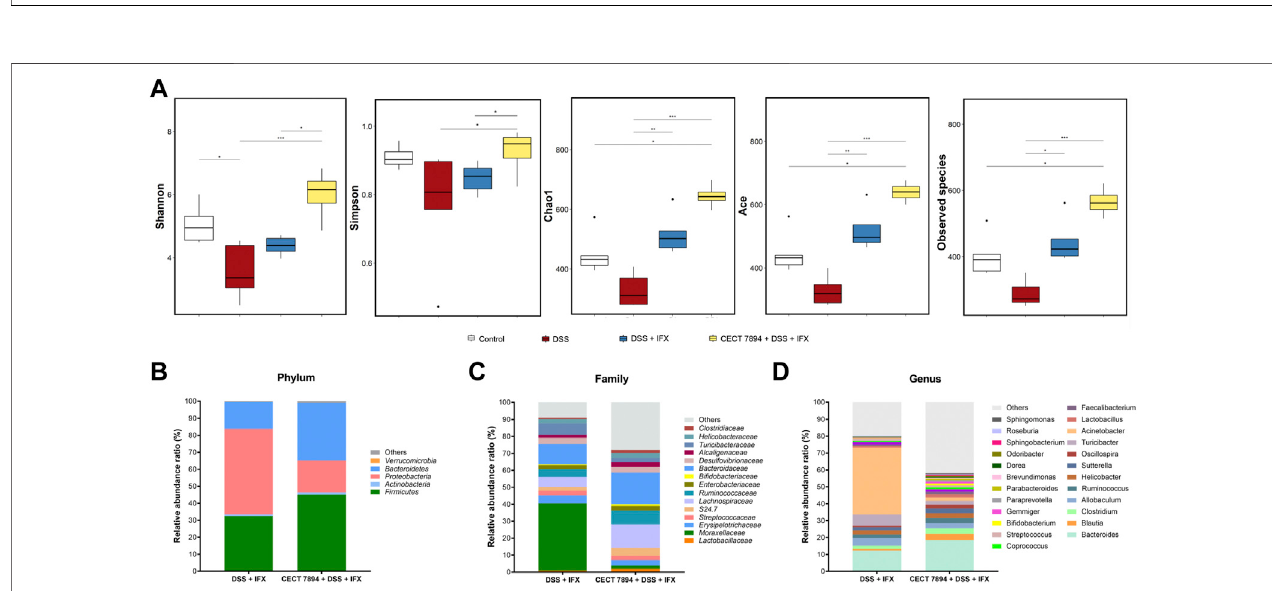
FIGURE 3 | B. longum CECT 7894 modulates the gut microbiota diversity and composition. (A) The alpha diversity evaluated by the Shannon, Simpson, Chao1, ACE, Observed species. (B) Relative abundance ratio of bacteria at the phylum levels. (C) Relative abundance ratio of bacteria at family levels with the top 15 detected families. (D) Relative abundance ratio of bacteria at the genera levels. Statistical signi fi cance was assessed by using Kruskal – Wallis H test and the Wilcoxon rank-sum test. * p ≤ 0.05, ** p ≤ 0.01, *** p ≤ 0.001.